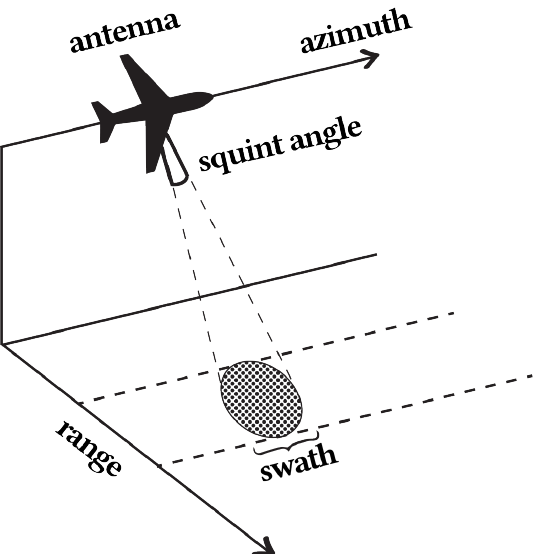
Figure 1. Schematics of an airborne SAR system. The airplane with the SAR system moves along the azimuth direction, illuminating a region called swath. The direction of the antenna is the range direction.